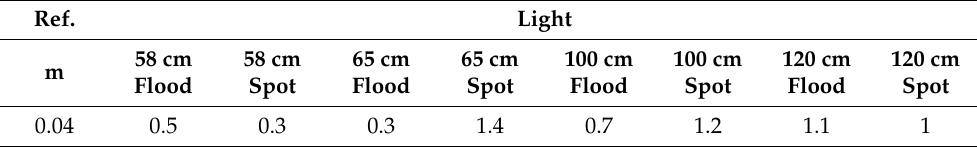
Table 2. Skewness of the real distribution and the measured ones.